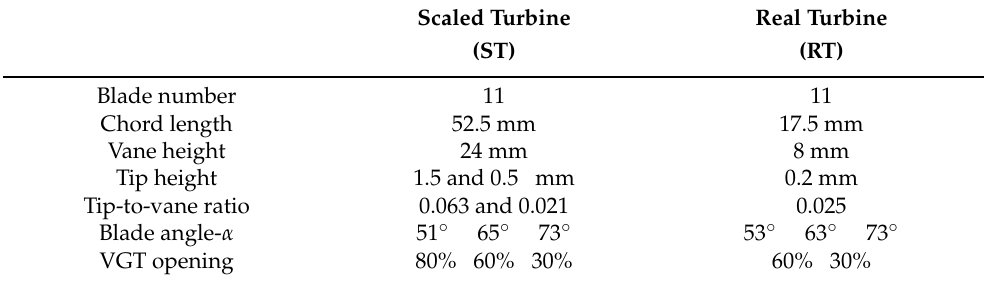
Figure 1. Printed nozzles with different vanes position. Table 1. Geometry